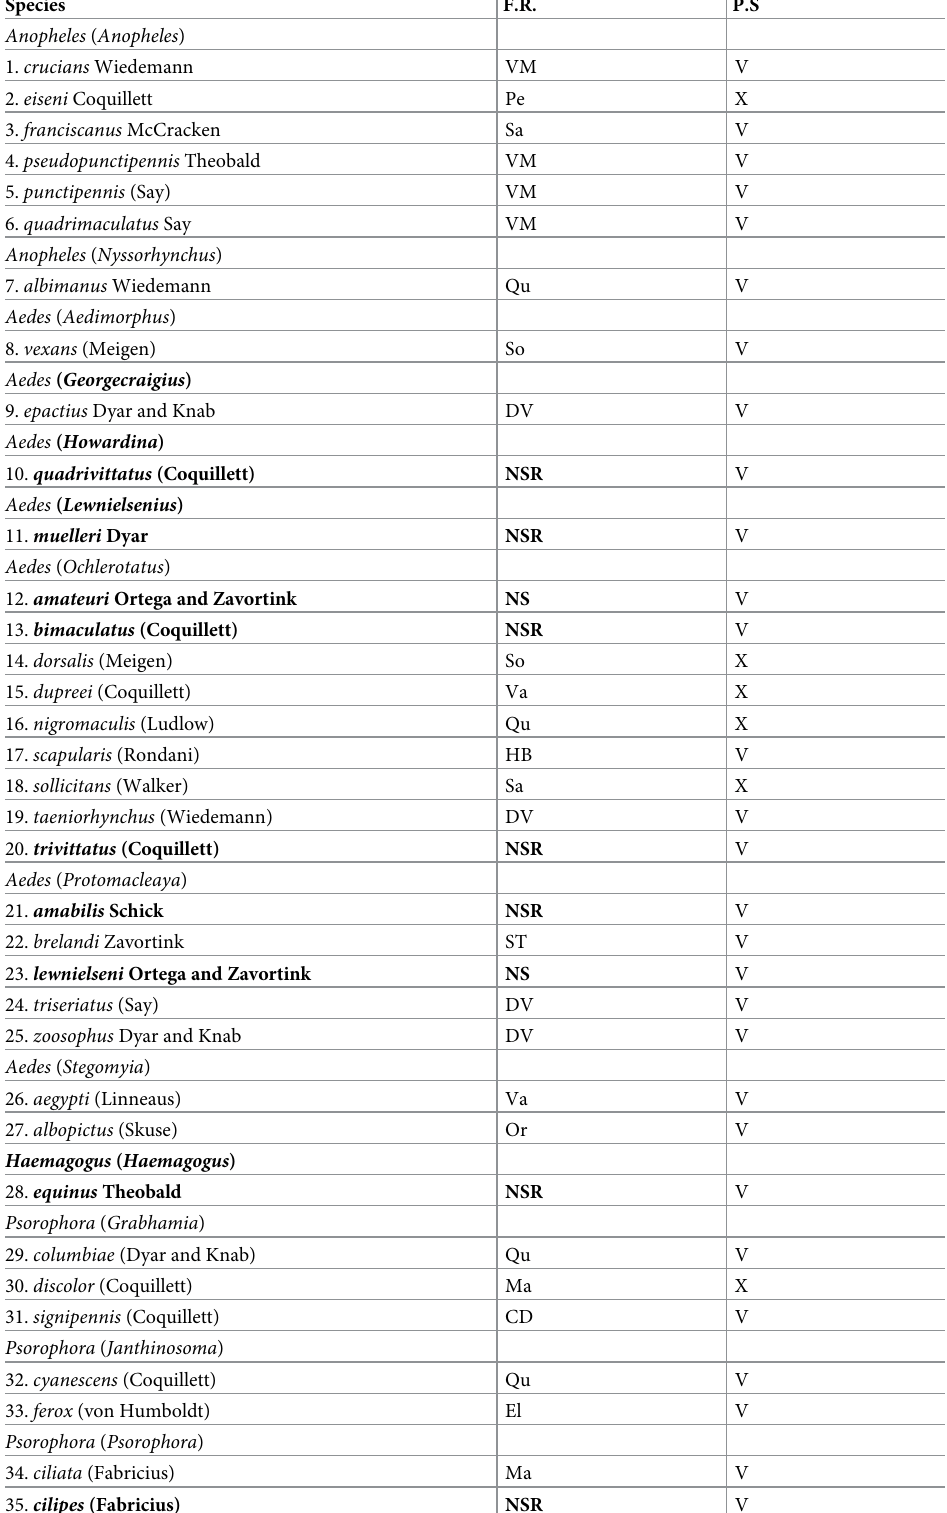
Table 1. Checklist of the mosquito species that occur in Nuevo Leo´n